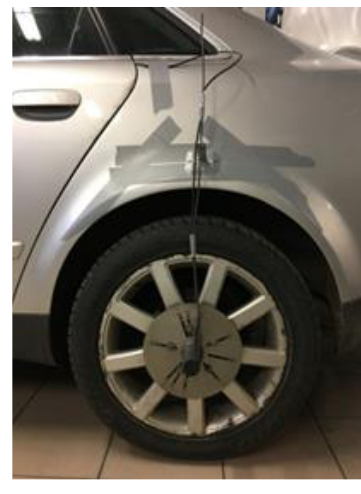
Fig. 7. Assembly of the road test bench Table 1. Results of power and torque